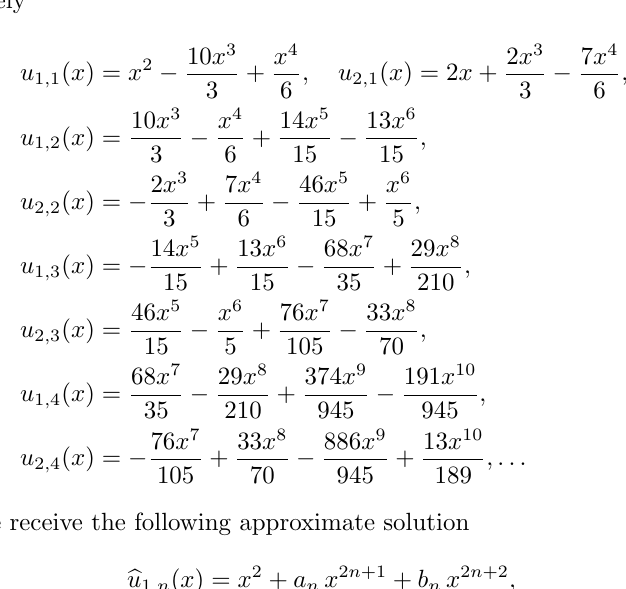
Figure 5. The h -curve ( a ) and squared residual E n ( h ) ( b ) for n = 3 , 5 , 8 , 10 (the successive curves from the top) Taking the optimum value of the convergence control parameter equal to − 1 ( h = − 1) and the initial approximation in form U 0 ( x ) = [0 , 0] T we